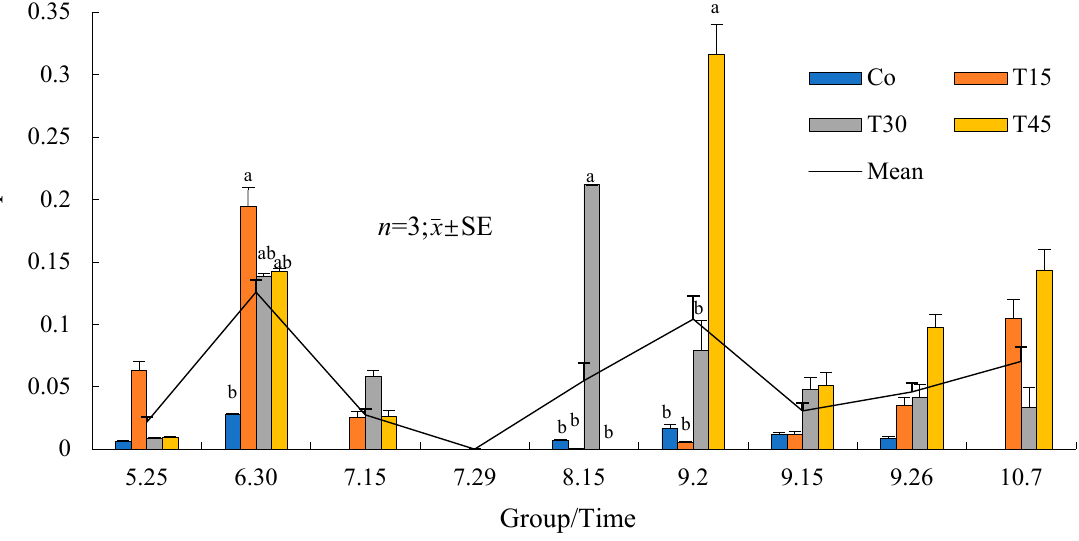
Figure 8. Dominance of Chroococcus sp. in different treatment groups during the experiment.